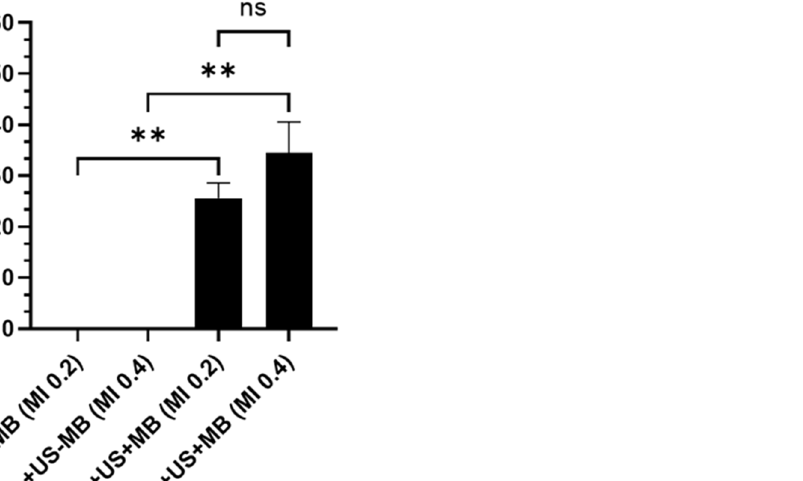
Figure 8. Quantification of the percentage of cells with intracellular accumulation of SYTOX TM green over the total number of cells lining blood vessels (n = 5), ** for p < 0.005, ns: not